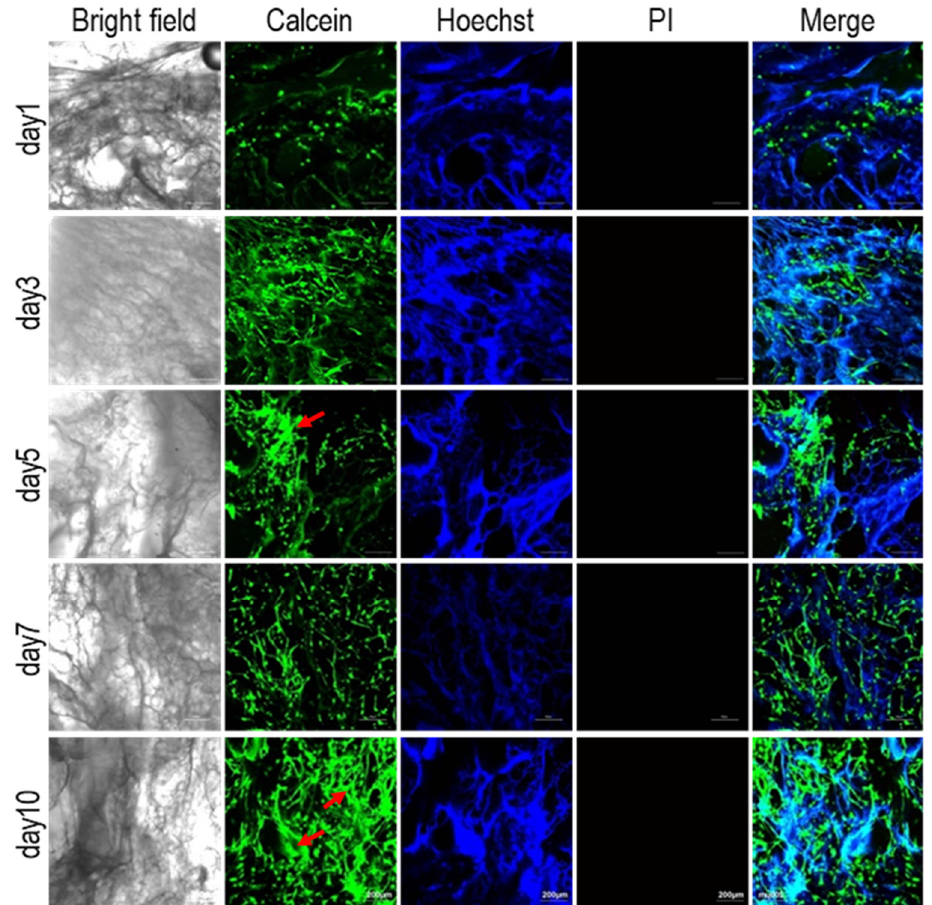
Figure 4. Growth of adipose tissue stem cells (ADSCs) on pig kidney-derived matrix scaffolds. The cells were dyed alive with calcein-Am, PI, and Hoechst 33,342, respectively; scale: 200 μ m. The red arrows indicate cell colonies.